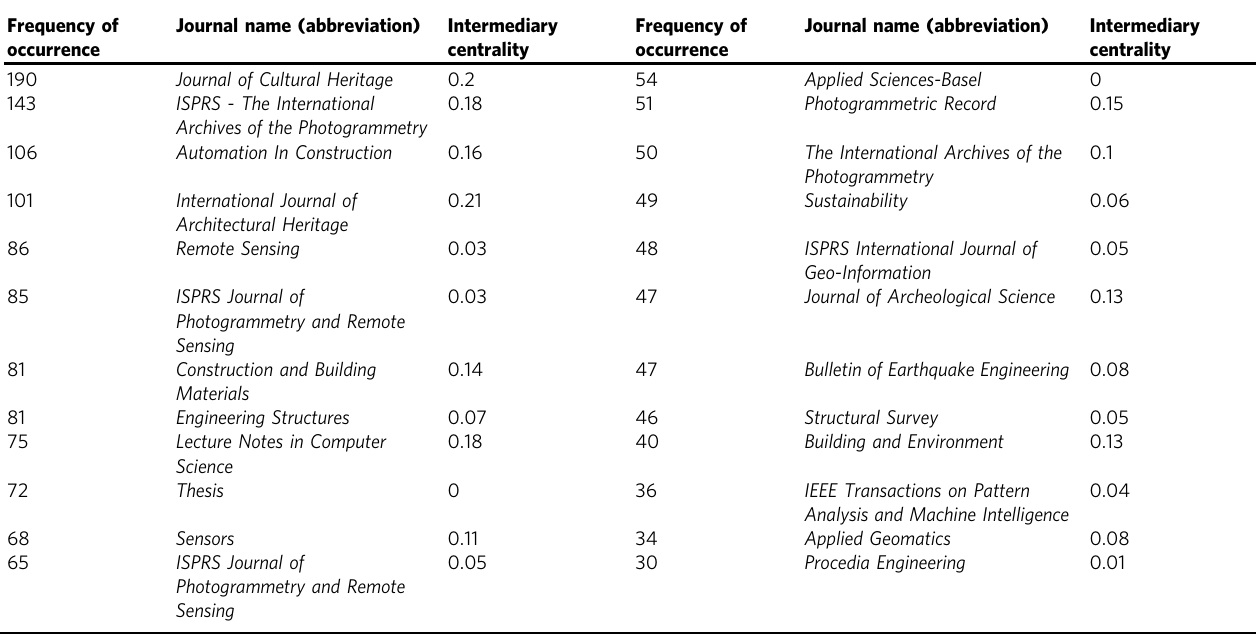
Table 6 Analysis of journal co-citations for HBIM